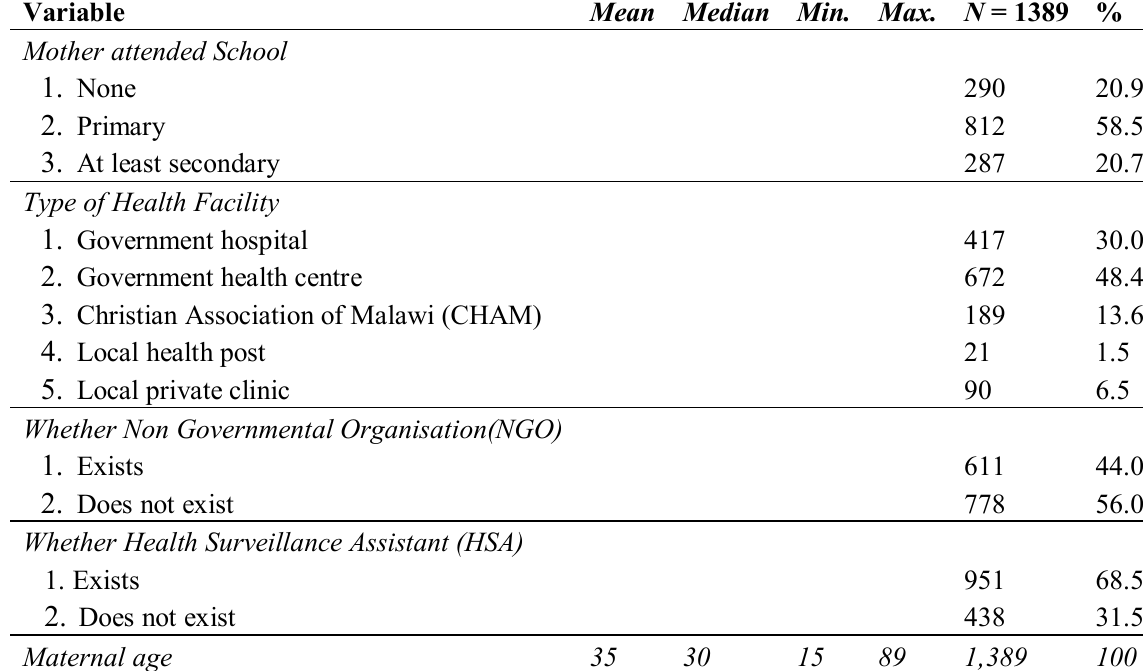
Table 2. Descriptive statistics for predictor variables on diarrhoea